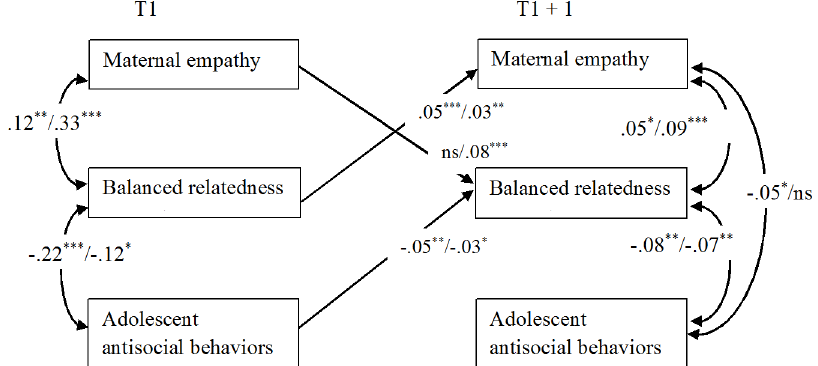
effect and correlation, the first result is based on adolescent reports (A) and the second on maternal reports (M). Since the models with time-invariant coefficients were retained as the final ones, we present only two time points (T and T+1), and all coefficients displayed represent the averaged standardized coefficients over the six time intervals. * p < .05, ** p < .01, *** p < .001.